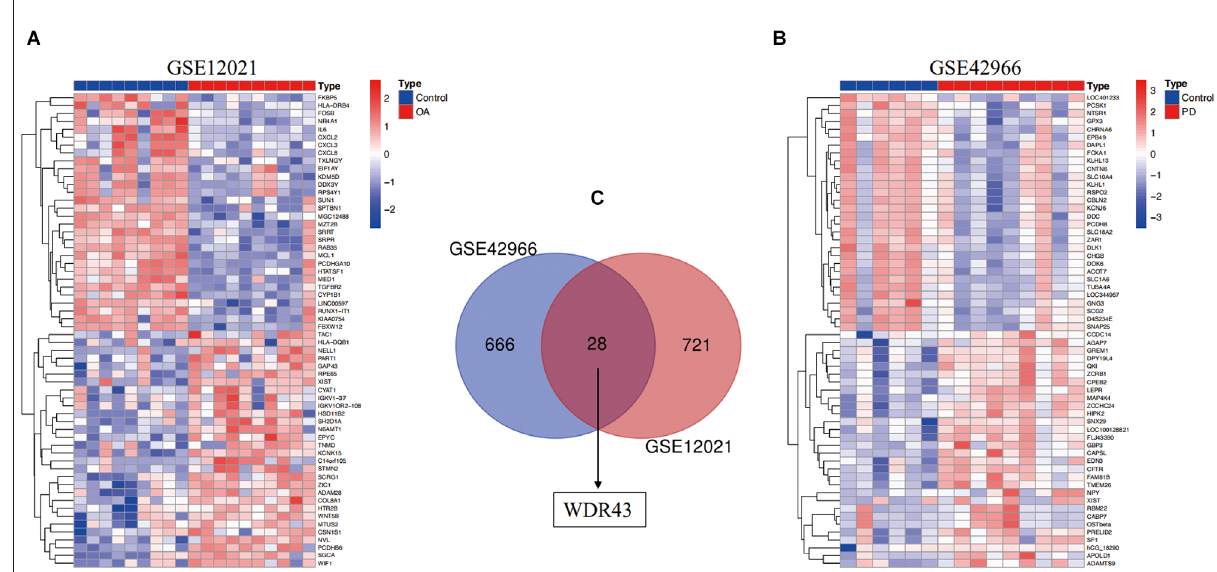
FIGURE7 (A) A heat map illustrating the hierarchical clustering of differentially expressed genes (DEGs) within the GSE12021 datasets. (B) A heat map illustrating the hierarchical clustering of DEGs within the GSE42966 datasets. (C) The GSE12021 and GSE42966 datasets were analyzed for the overlap of DEGs. WDR43 were also DEGs in genes shared by the GSE42966 (blue) and GSE12021 (red)